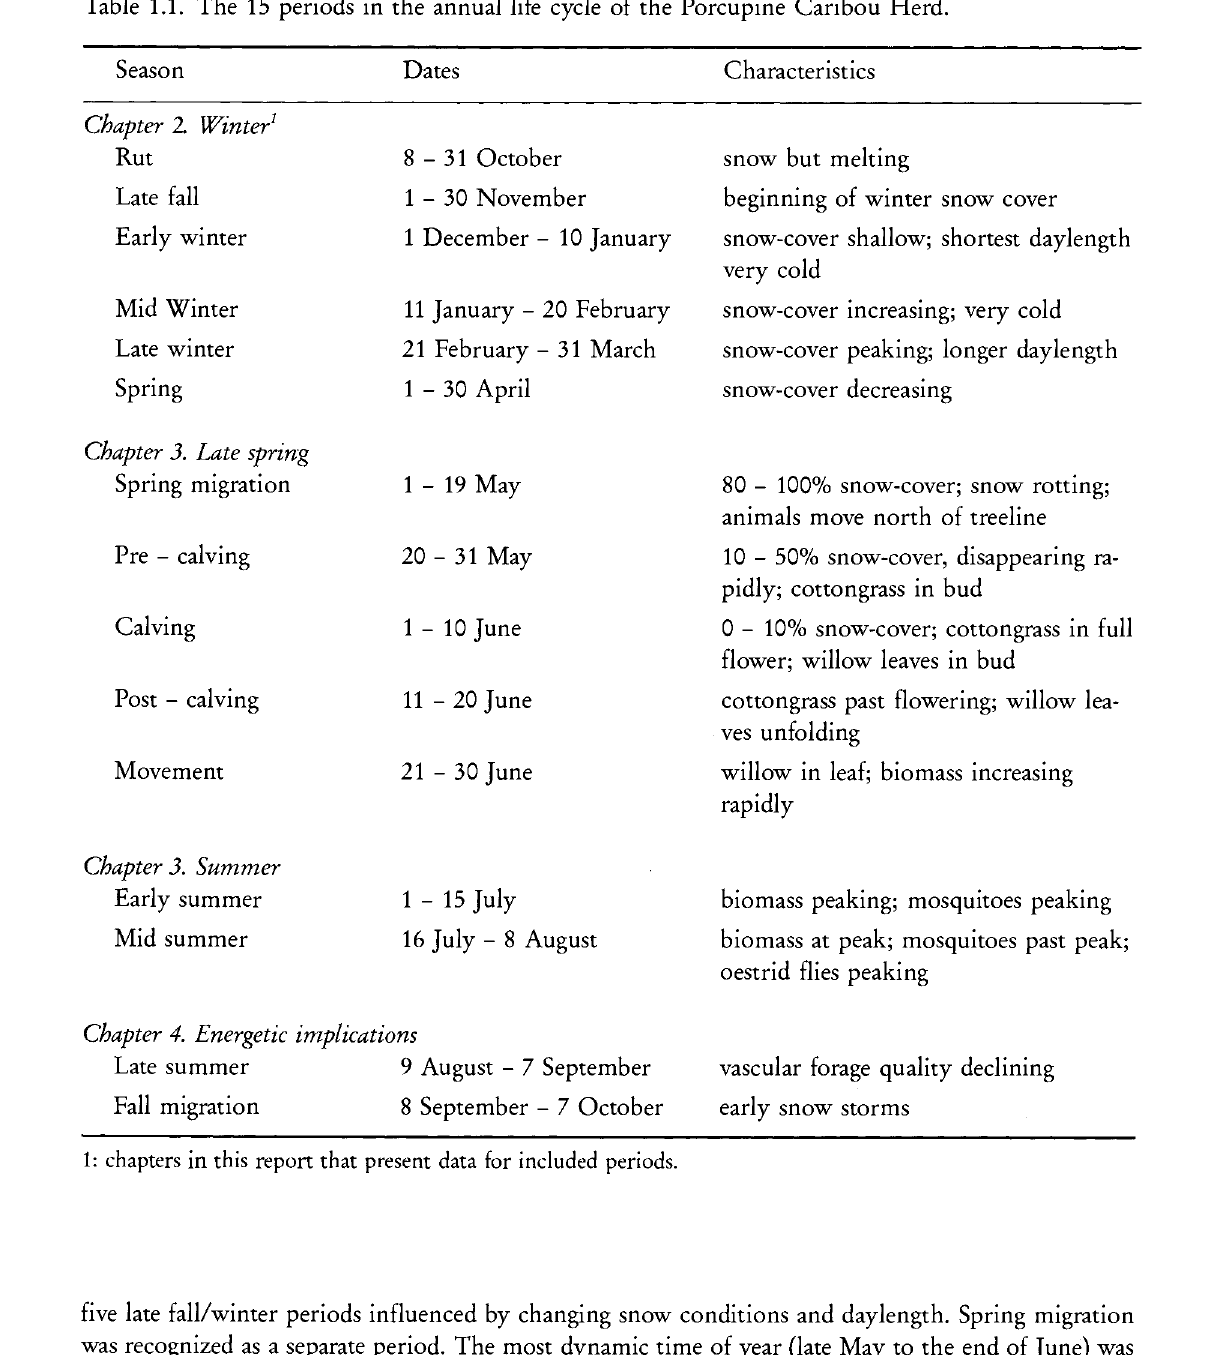
Table 1.1. The 15 periods in the annual life cycle of the Porcupine Caribou Herd. Season